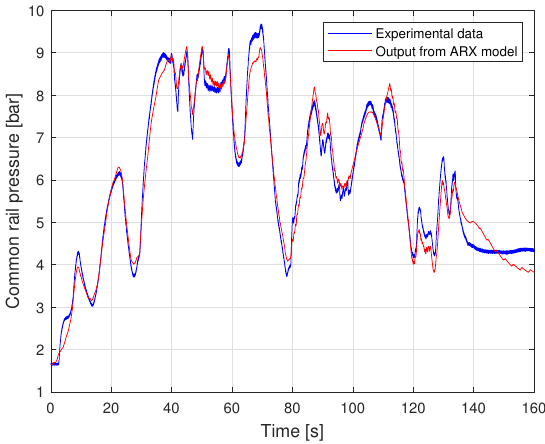
Figure 8. Comparison between experimental and simulated common-rail